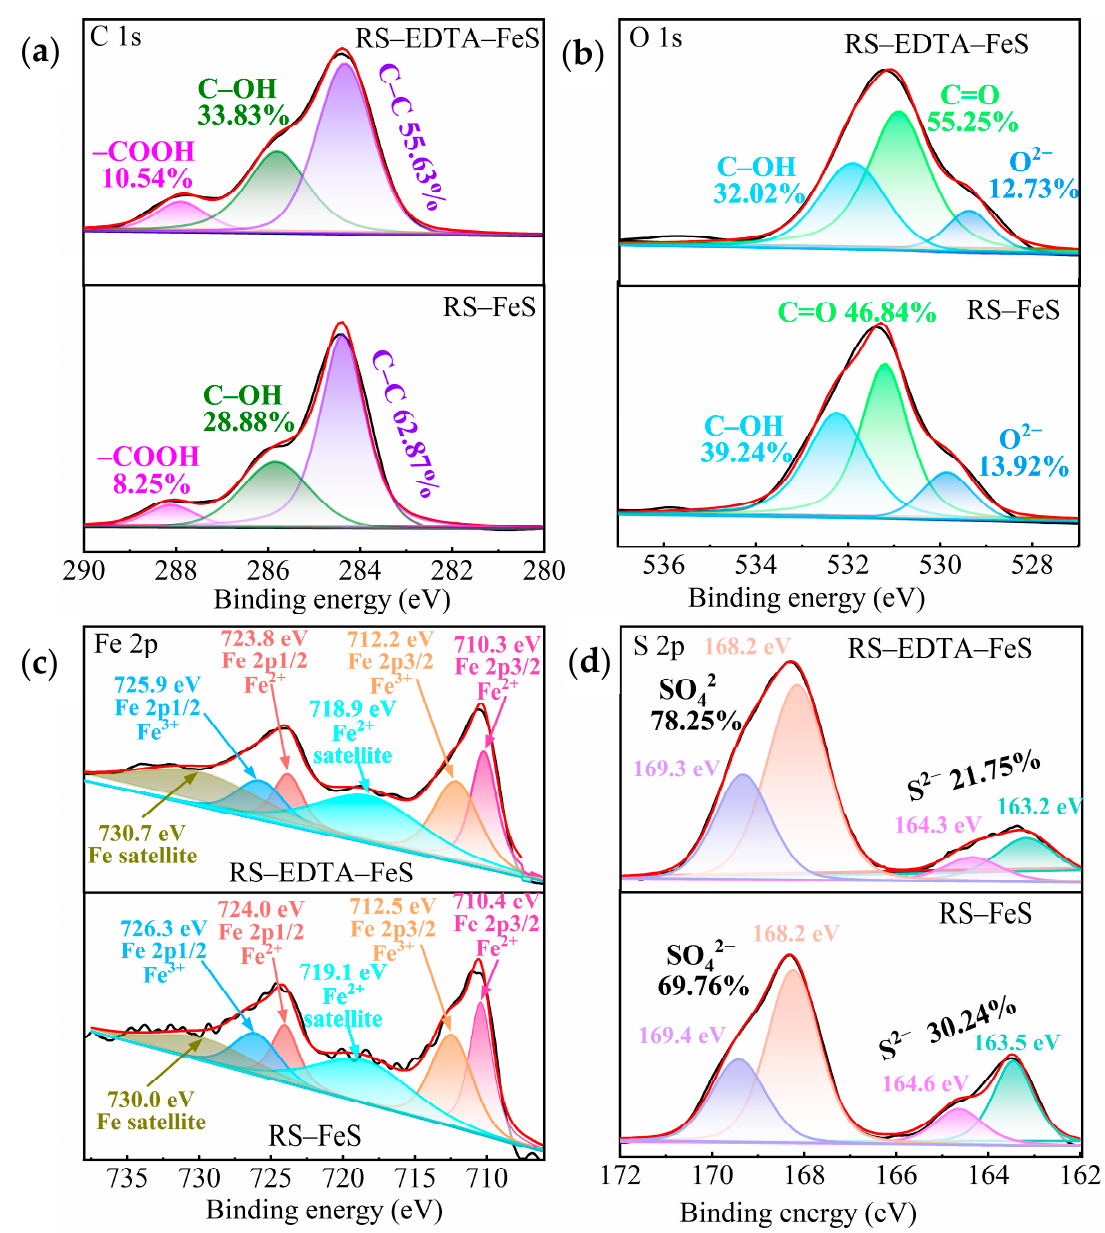
Figure 3. C 1s XPS spectra ( a ), O 1s XPS spectra ( b ), Fe 2p XPS spectra ( c ), and S 2p XPS spectra ( d ) of RS–FeS and RS–EDTA–FeS.